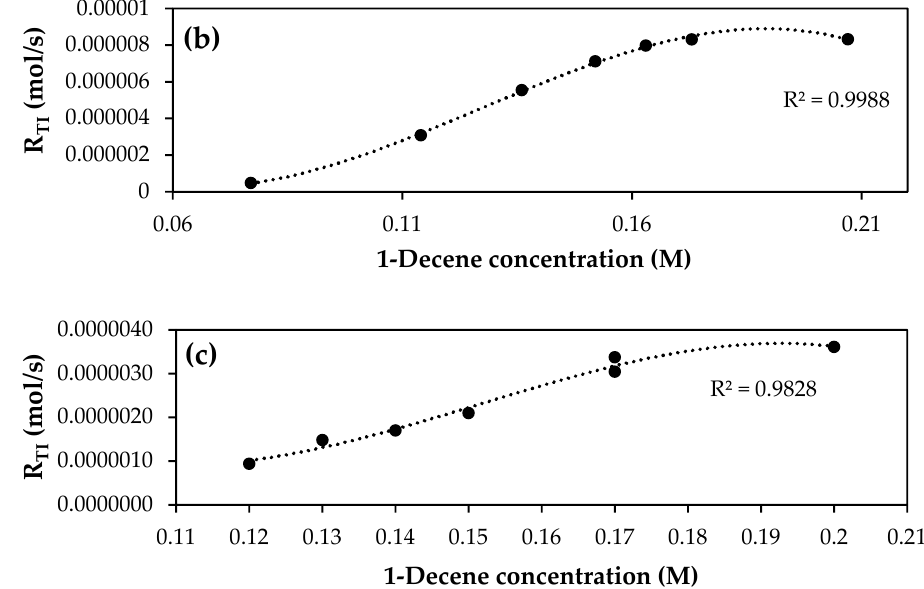
Figure 7. Fitting of the proposed trimerization rate equation with experimental data at ( a ) 423 K, ( b ) 443 K and ( c ) 483 K. Experimental data are plotted as symbol and calculated data are plotted as dash line.